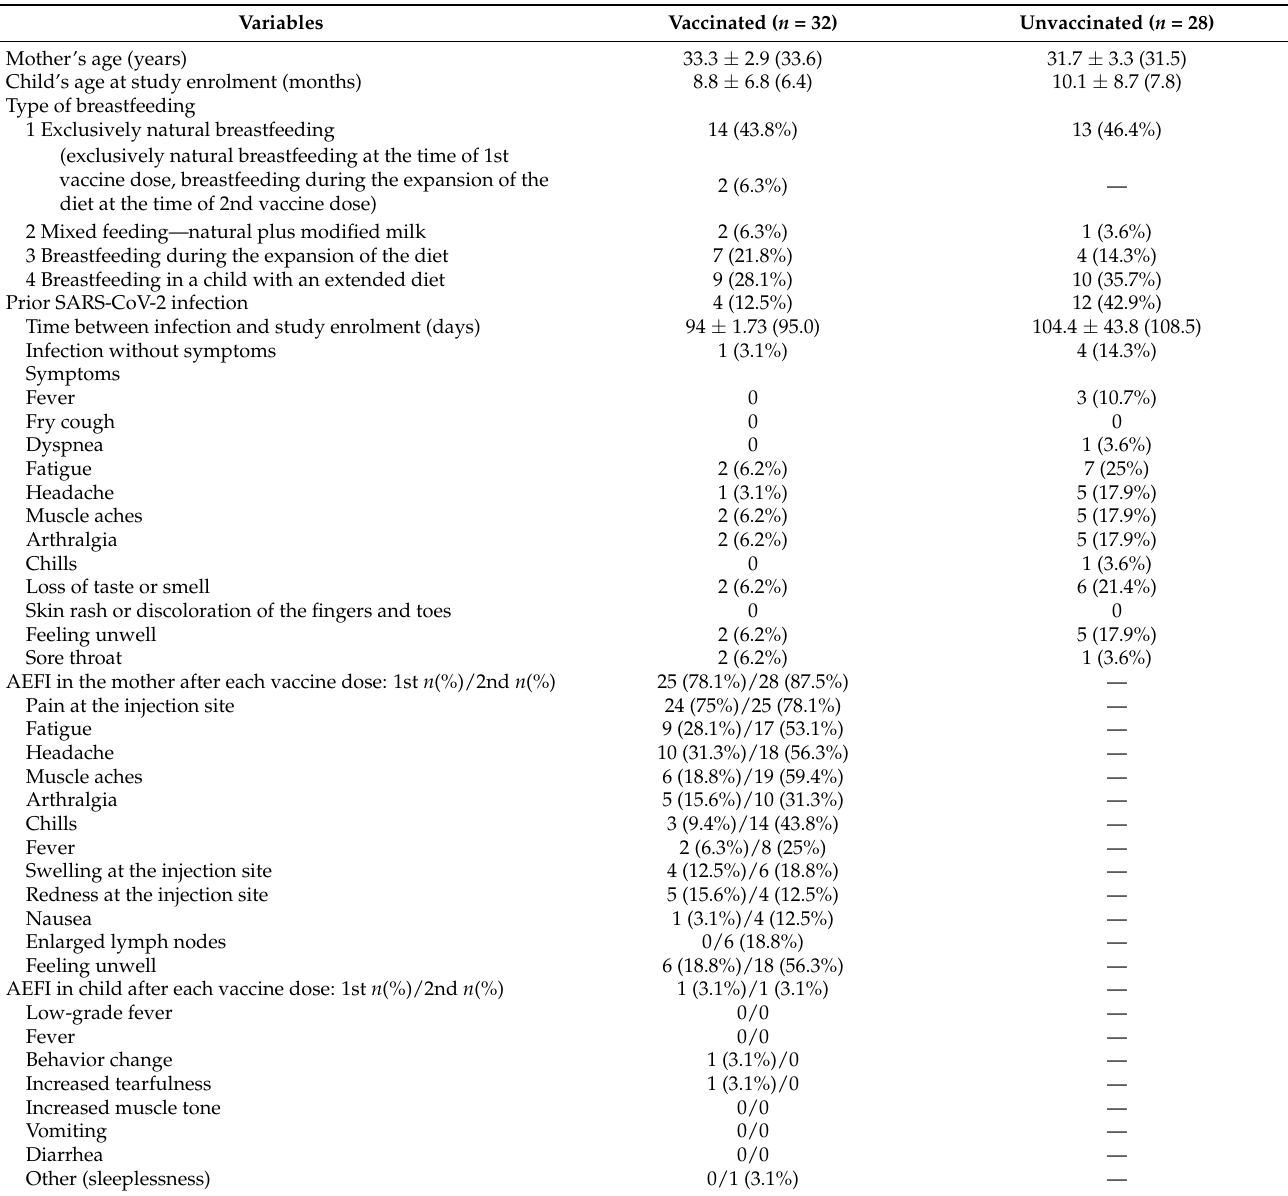
Table 1. Study population